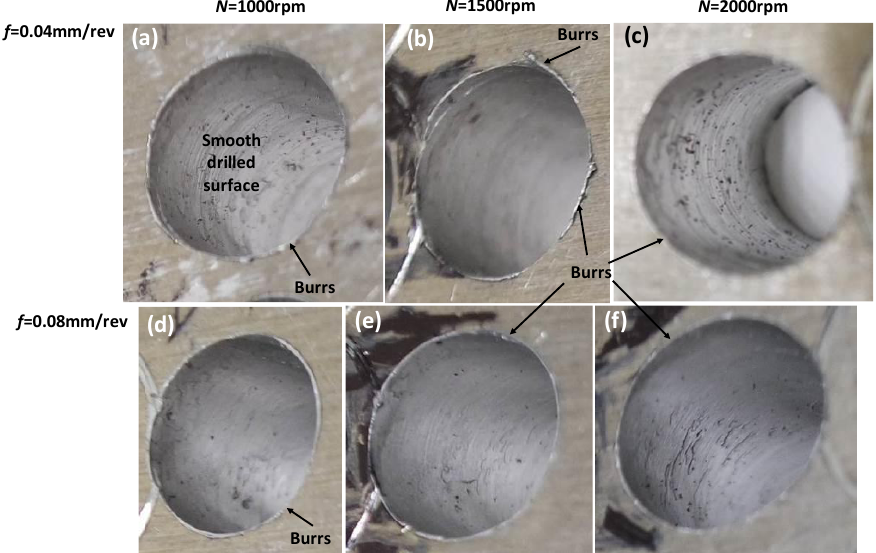
Figure 9. Representative topography of exit side of holes at parameter combination of ( a ) N = 1000 rpm and f = 0.04 mm/rev, ( b ) N = 1500 rpm and f = 0.04 mm/rev, ( c ) N = 2000 rpm, f = 0.04 mm/rev, ( d ) N = 1000 rpm, f = 0.08 mm/rev, ( e ) N = 1500 rpm, f = 0.08 mm/rev ( d ) N = 2000 rpm, f = 0.08 mm/rev.